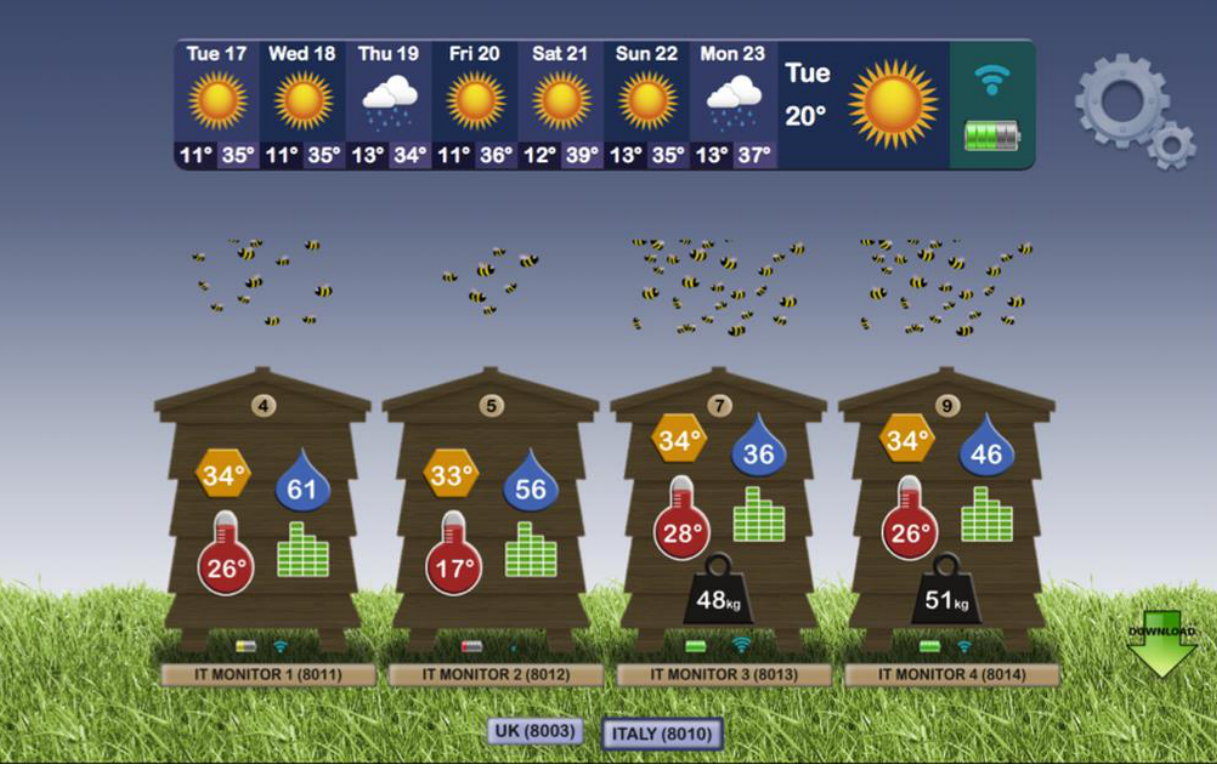
Figure 8. Arnia’s Remote Hive Monitoring web-based reporting system [89]. The interface is intuitive and works well for